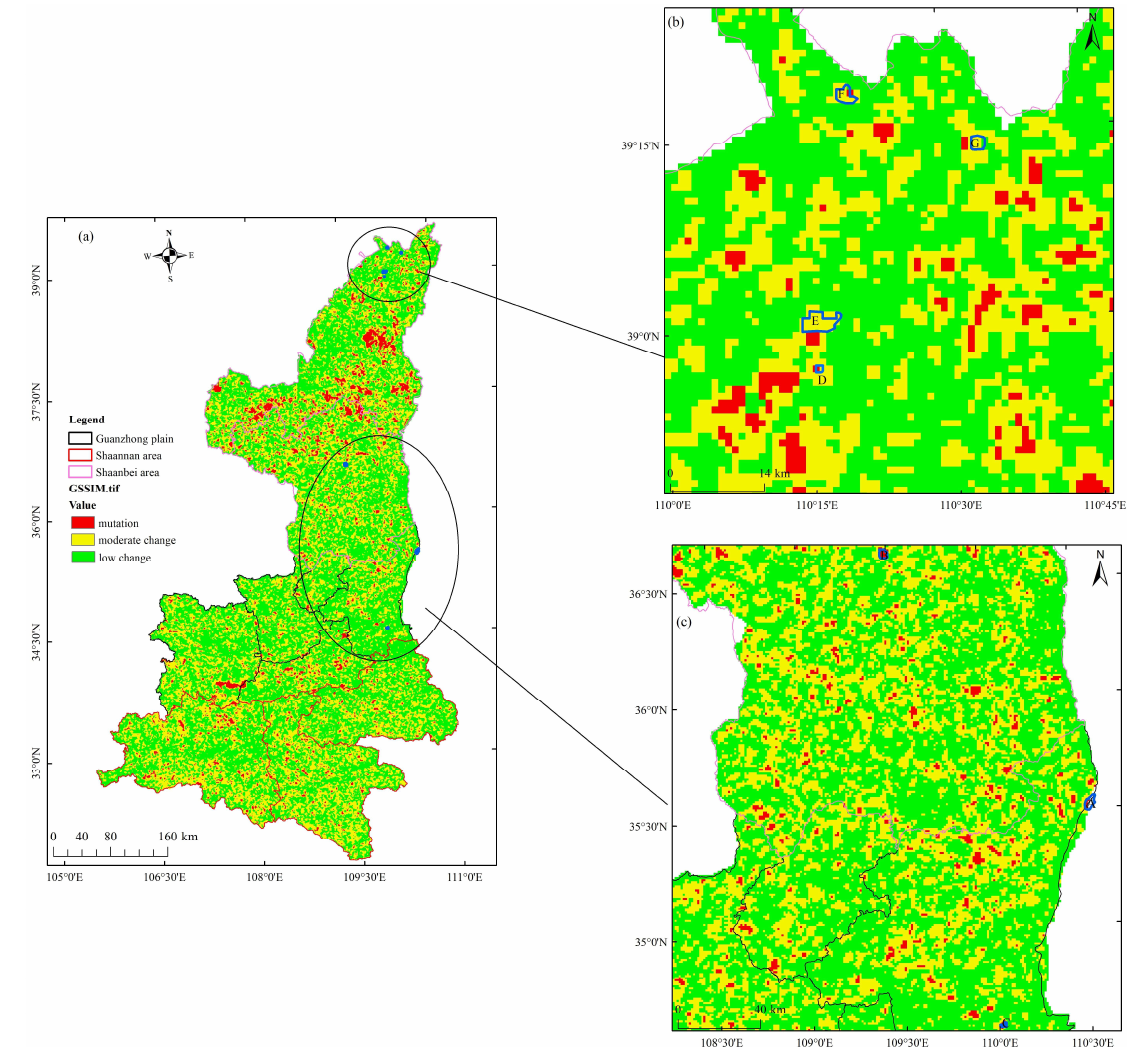
Figure 7. The location of samples. ( a ) GSSIM between 2008 and 2015, ( b ) Samples of D, E, F, and G, ( c ) Samples of A, B, and C.